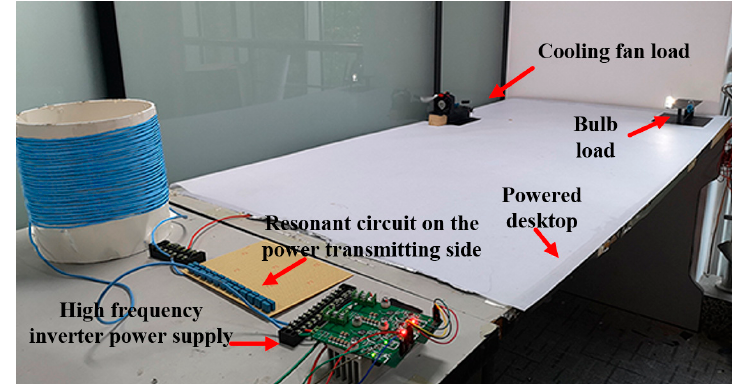
Figure 18. DWPT system multiple types of load experiments.